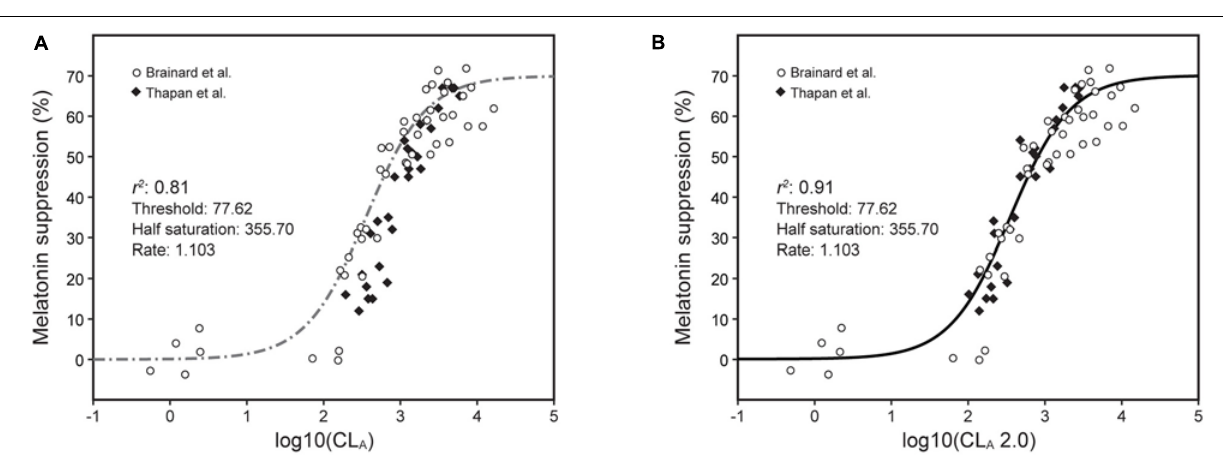
FIGURE 6 | Nocturnal melatonin data for different narrowband light sources from Brainard et al. (2001) (open circles) and Thapan et al. (2001) (solid diamonds) along with predictions from the 2005 CS model (Rea et al., 2005, 2012; Rea and Figueiro, 2018) [Eqs. 1 and 2, dashed line, (A) ] and from the revised CS t , f model [Eqs. 3 and 5, solid line, (B) ] using the appropriate temporal duration and spatial distribution terms, t and f ,